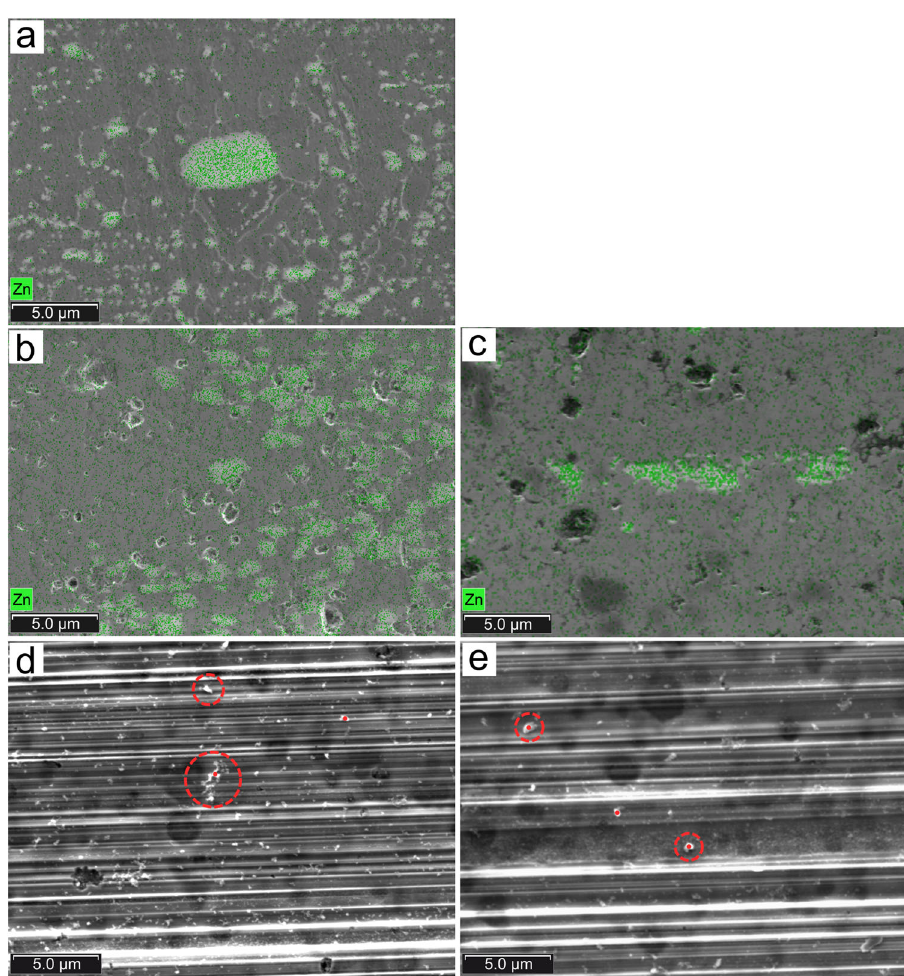
Fig. 3 Representative SEM images of DLC surfaces after sliding in PAO + ZDDP. SEM images for a a-C:H, b a-C, c ta-C(51), d ta-C(66), and e ta-C(78). ZDDP-derived species are indicated by green dots in a − c and by dashed red circles in d and e